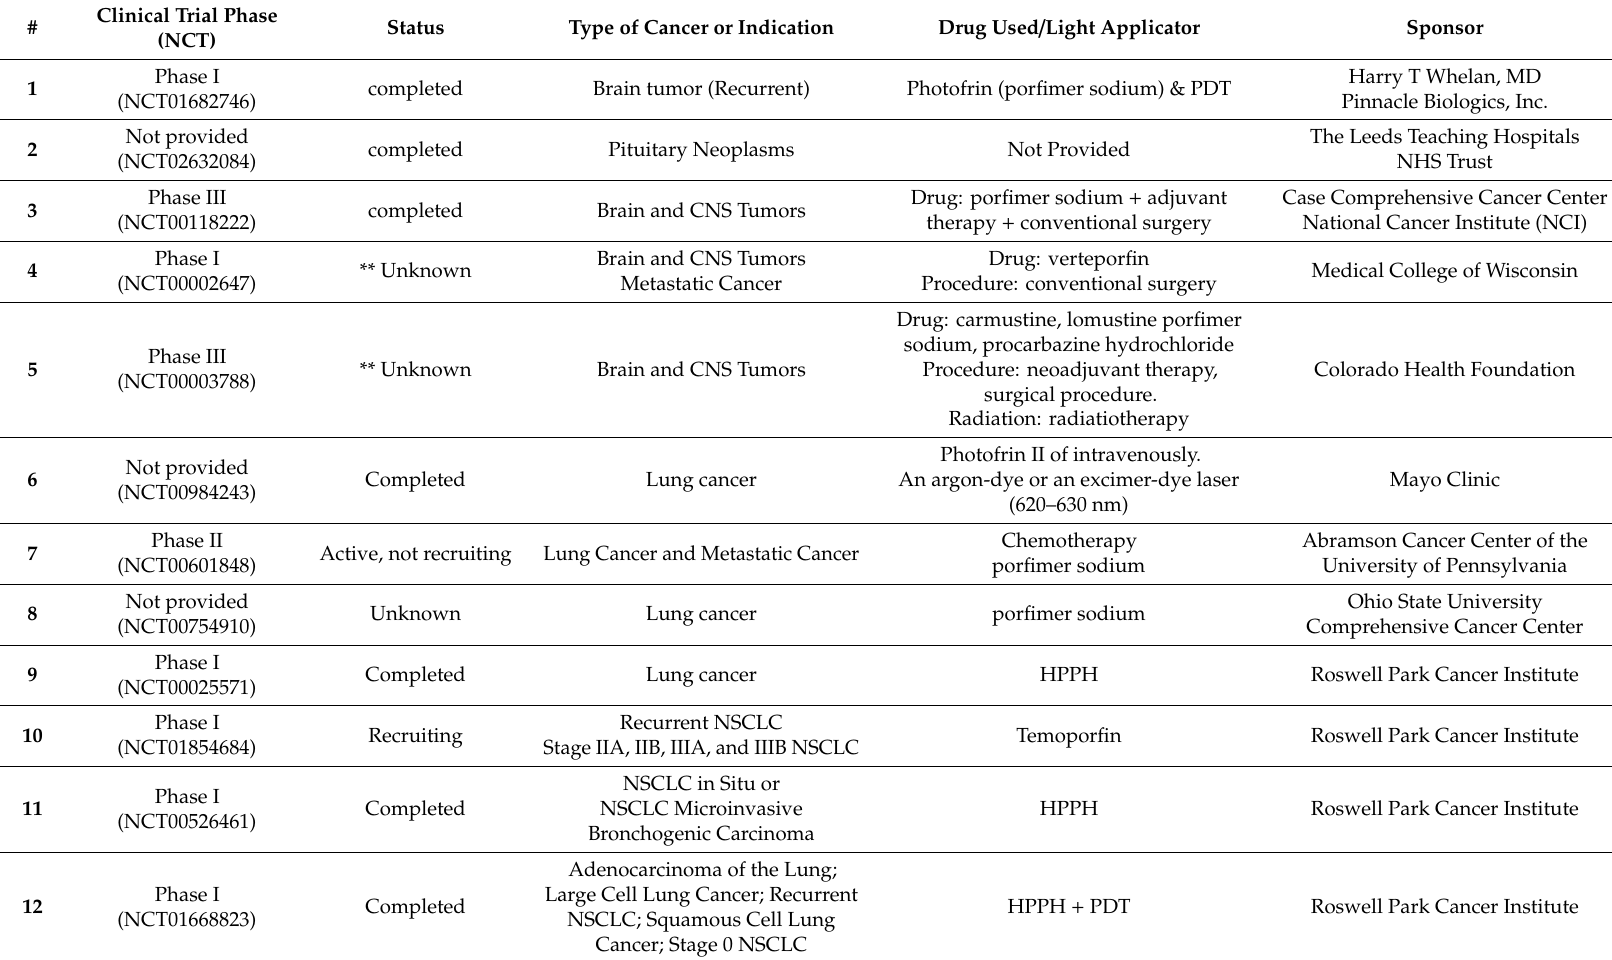
Table 1. Clinical trials of the photodynamic therapy of brain tumors, lung cancers, and bladder